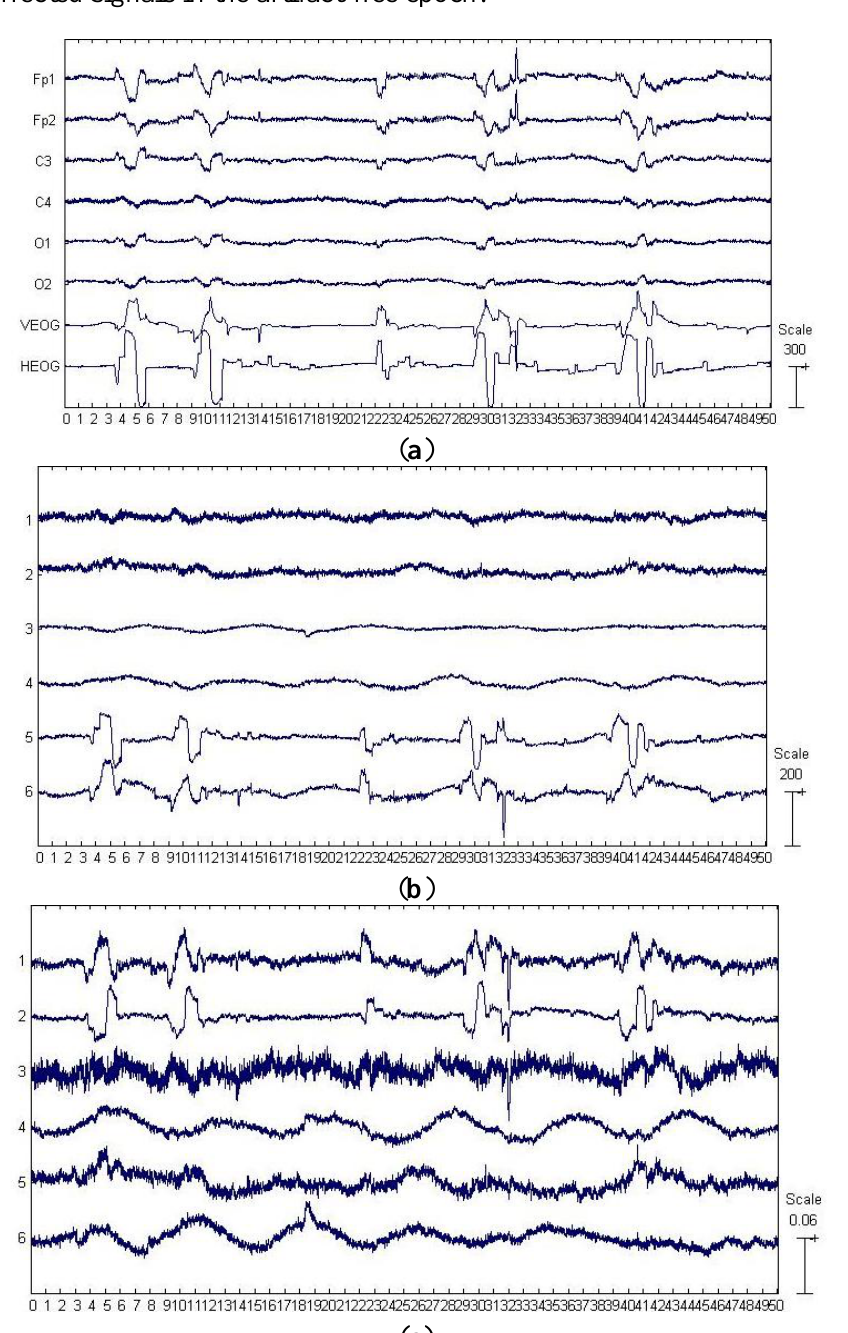
Figure 3. Results of EOG artifact removal on an example EEG data set from the 20 artificially contaminated ones. ( a ) The artificially contaminated EEG data with eye movement and blink artifacts (shown in the first six EEG channels) and the corresponding EOG signals used in the mixing procedure (shown in the last two channels); ( b ) Components separated by SSA; ( c ) Components separated by SOBI; ( d ) Components separated by ICA; ( e ) IMFs decomposed by applying EMD on the last two components in (b); ( f ) The mixed, the pre-contaminated EEG and the corrected EEG signals by each methods on channel Fp1; ( g ) The power spectrum estimates for the pre-contaminated EEG and the corrected EEG signals by each methods on channel Fp1; ( h ) The zoomed artifacts-corrected signals in the artifact-free